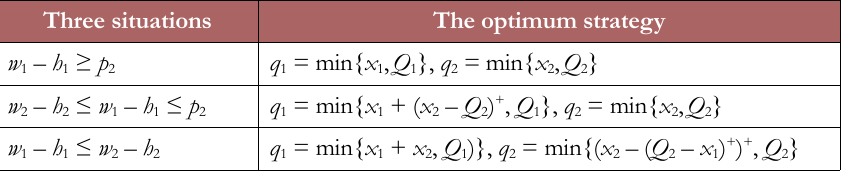
Table 2. Conclusion for optimum strategy of three mentioned